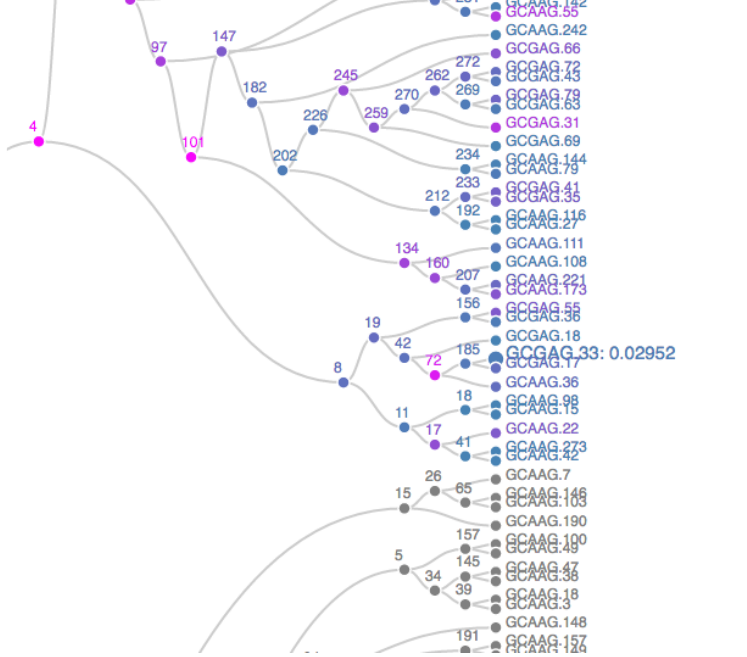
Figure 28. A screenshot of a subtree with many differentially abundant bacteria, as determined by the hierarchical testing procedure. Currently the user is hovering over the node associated with bacteria GCGAG.33; this causes the adjusted p -value (0.0295) to